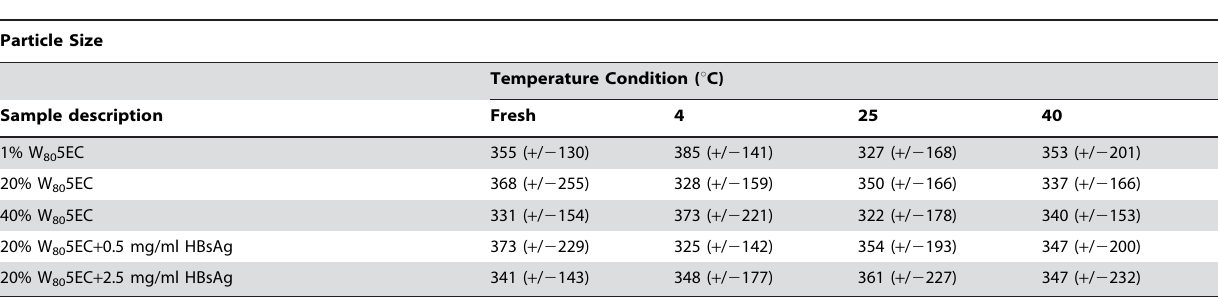
Table 1. Consistency of nanoemulsion particle